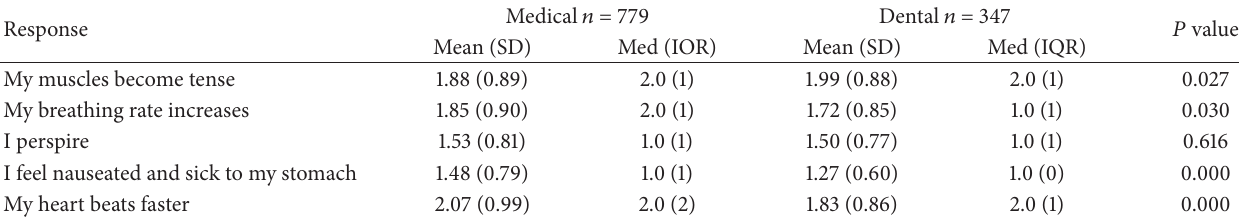
Table 1: Kleinknecht’s score of physiologic responses during dental treatment.